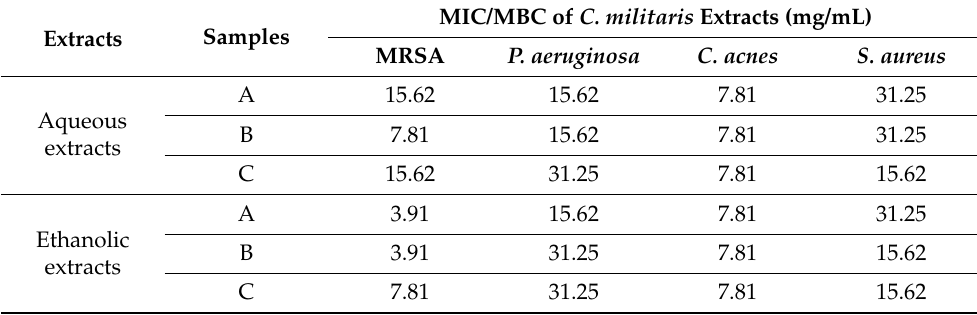
Table 6. Minimal inhibitory concentration (MIC) and minimal bactericidal concentration (MBC) values of C. militaris extracts against skin pathogenic